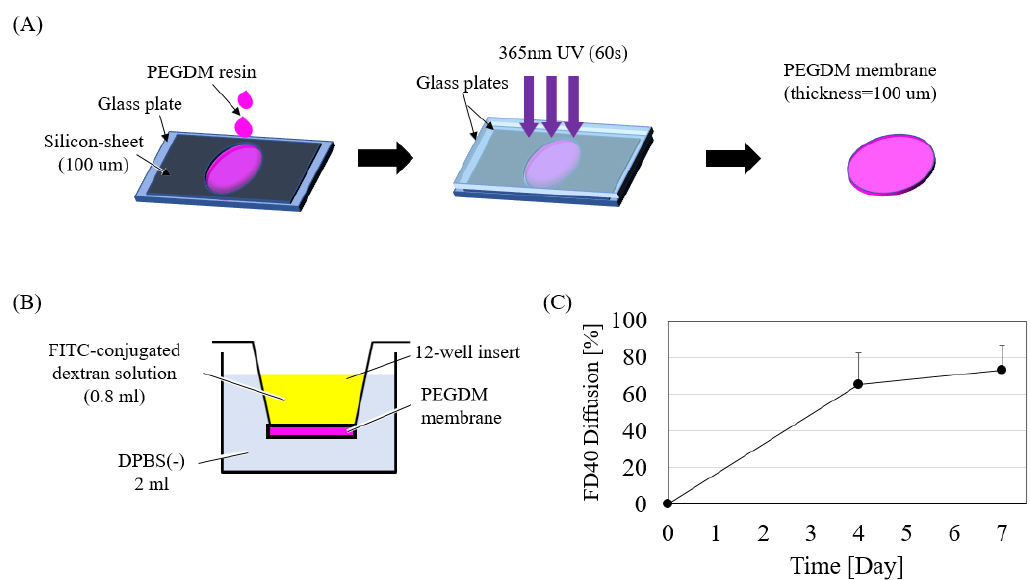
Figure A3. Fabrication of PEGDM membrane and in-vitro diffusion test. ( A ) PEGDM resin sandwiched between glass and a 100 µm thickness silicon-sheet with a round cut was cured using 365 nm UV lamp for 60 s. ( B ) The 12-well transwell insert membrane was replaced with a PEGDM membrane for diffusion test. ( C ) Percentage diffusion of FD40 (n = 3). The error bar represents standard deviation.